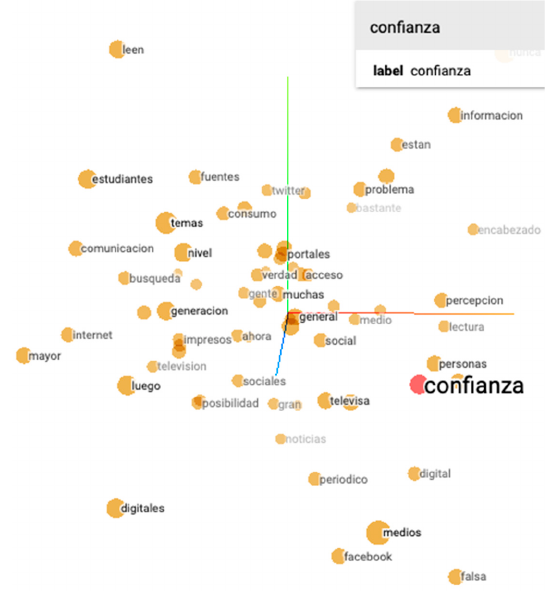
Figure 4. Visualization of the “trust” vector.